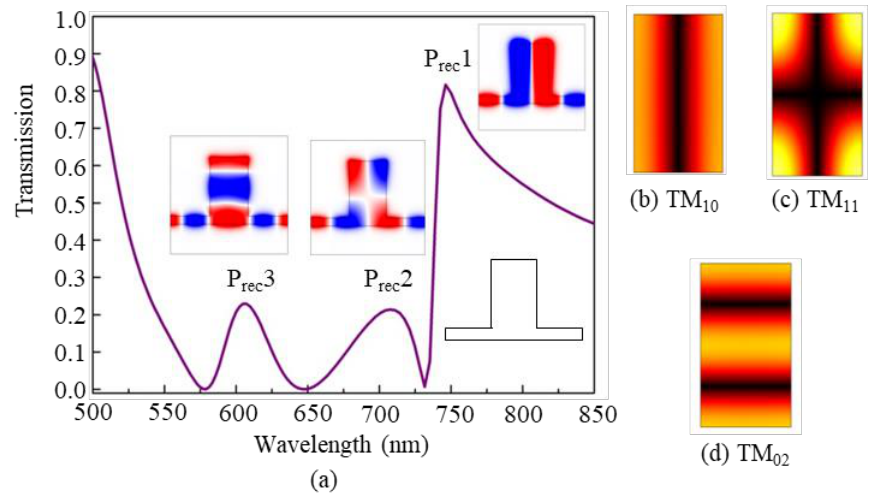
Figure 4. ( a ) The transmission of the rectangular cavity coupled with a waveguide, where the black-line inset indicates the detailed structure, and the color insets show the simulated magnetic-field H z distributions at the transmission peaks of modes P rec 1 ( λ = 746 nm), P rec 2 ( λ = 709 nm), and P rec 3 ( λ = 606 nm). ( b ) The | H | distributions of TM 10 mode, ( c ) of TM 11 mode, and ( d ) of TM 02 mode, in the rectangular cavity not coupled with a waveguide.